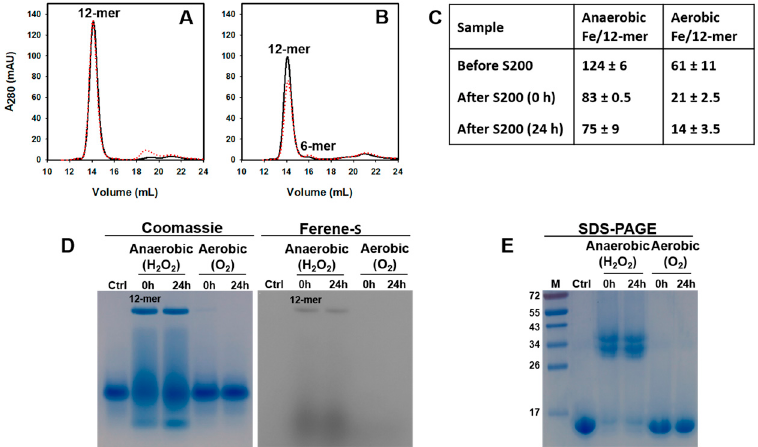
Figure 6. The oxidation of Fe 2+ at Pa Dps ferroxidase centers requires H 2 O 2 . Pa Dps titrated anaerobically with Fe 2+ and H 2 O 2 ( A ) and with Fe 2+ in air ( B ), was separated in a calibrated Superdex S200 column immediately after the titration (0 h; black trace) and after 24 h at 4 °C (24 h, red). ( C ) Iron associated with 12-mer Pa Dps before and after passage through a Superdex S200 column. Standard deviation is from two independent experiments. ( D ) Twelve-mer Pa Dps eluting from the Superdex S200 column was separated in a native PAGE gel and stained first with Ferene S to visualize iron and then with Coomassie to visualize the protein. ( E ) Twelve-mer Pa Dps eluting from the Superdex S200 column was loaded onto an SDS PAGE gel and stained with Coomassie. Ctrl = 12-mer Pa Dps (75 mM tris, pH 7.5, 1 mM Mg 2+ ) not titrated with iron, M = molecular weight marker.